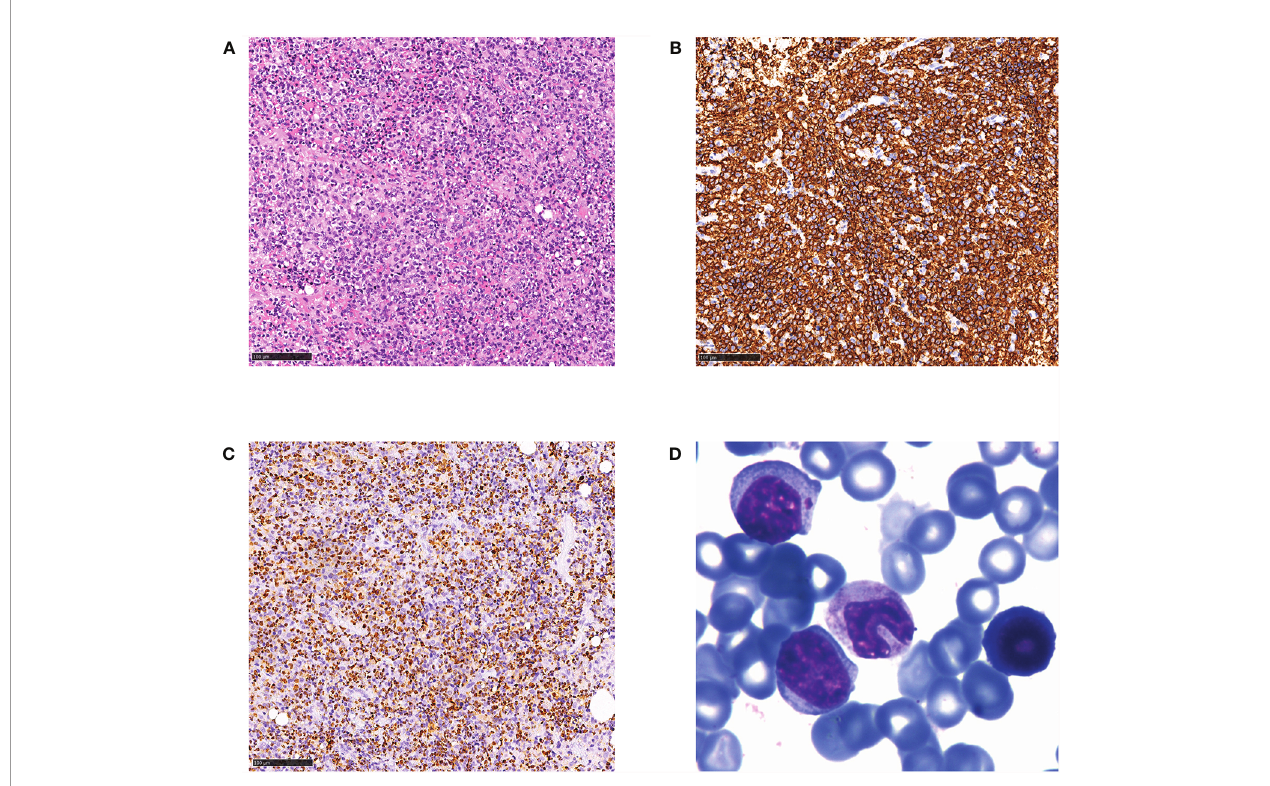
FIGURE 2 | Histological and immunophenotypic results of excisional biopsy of the axillary lymph node and peripheral blood smear. H&E-stained sections is seen (A) , and immunohistochemical staining of the specimens shows that the diffuse in fi ltrated lymphocytes are positive for CD20 (B) and EBER (C) (magni fi cation ×20). Wright ’ s staining of peripheral blood smear showed typical atypical lymphocytes (D) (magni fi cation